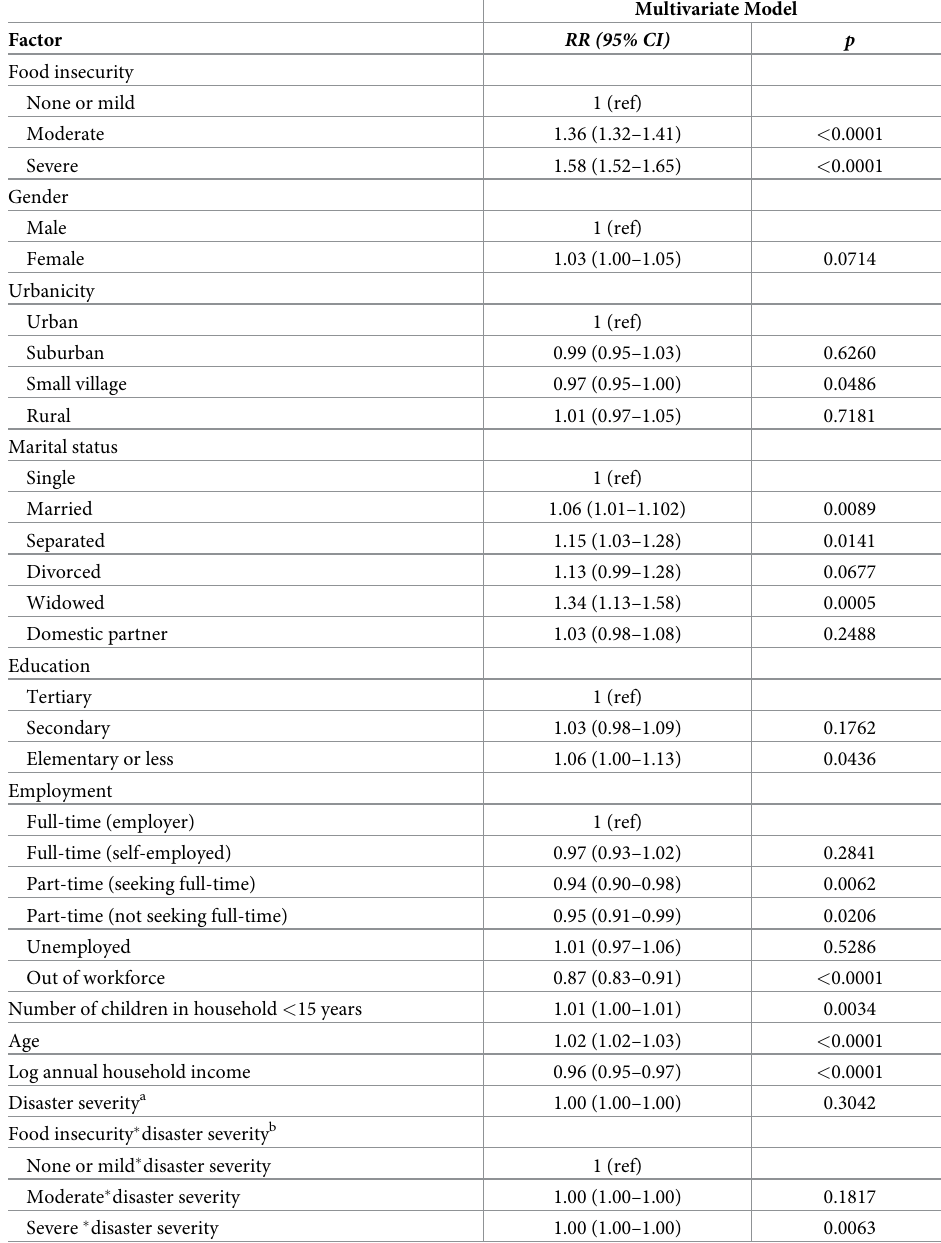
Table 3. Multivariate multilevel negative binomial regression model examining the association between food inse- curity (Food Insecurity Experiences Scale) and poor mental health (Daily Experience Index score) among n = 28,292 youth from the 2017 Gallup World Poll